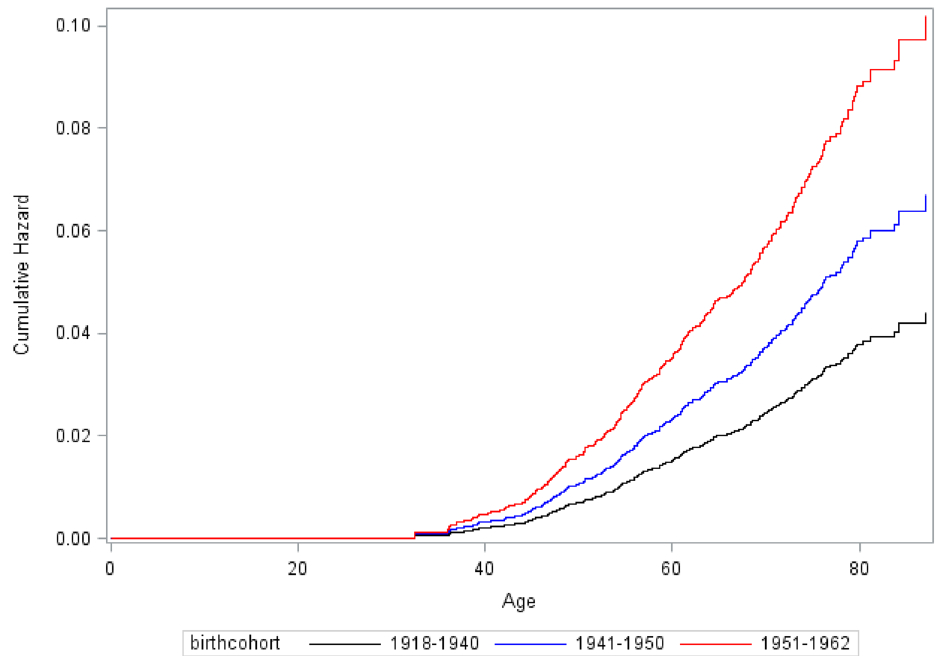
Figure 1. The cumulative hazard of breast cancer in Taiwanese women by different birth cohort.